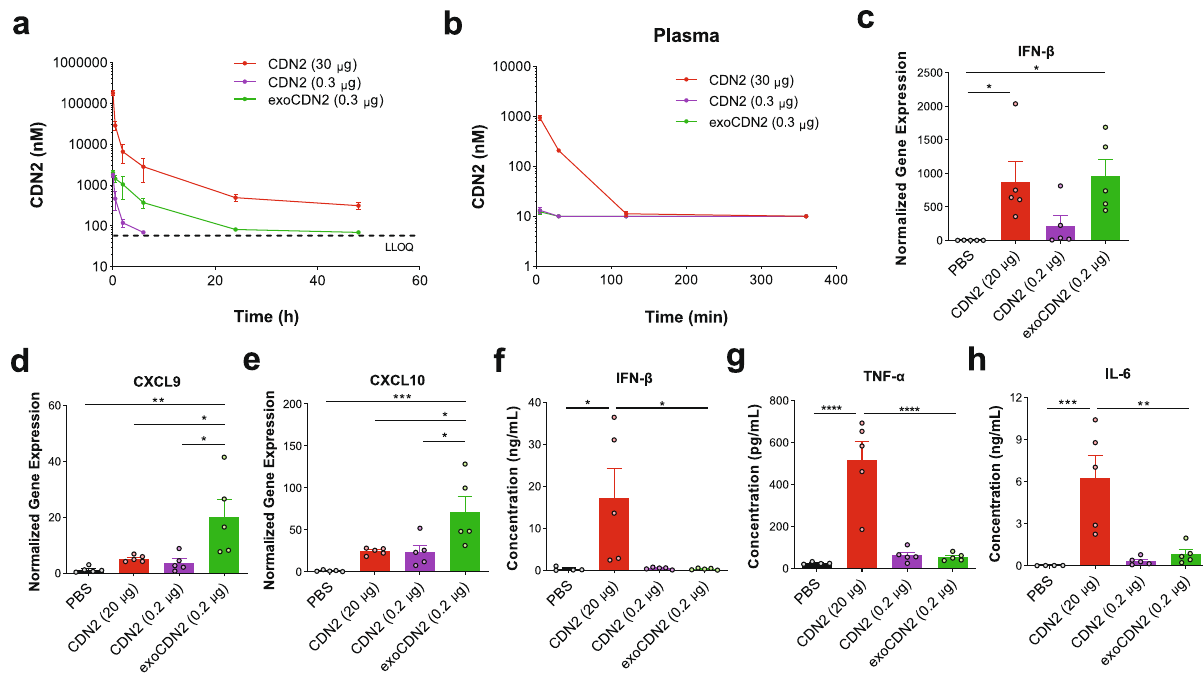
Fig. 3 Intra-tumoral administration of exoSTING enhances pharmacokinetics of a CDN and immunostimulatory activity in tumor microenvironment. a – h C57BL/6 mice were implanted subcutaneously with 1 × 10 6 B16F10 cells. Concentration of CDN2 in tumors ( a ) and plasma ( b ) was measured by LC- MS/MS at 5 and 30 min, 2, 6, 24, and 48 h after single IT injection ( n = 3 animals per group at each time point, n = 6 animals for CDN2 (30 µ g) and exoCDN2 (0.2 µ g) at 5 and 30 min, 2 and 6 h). c – e Four hours after IT injection, RNAs were puri fi ed from tumors ( n = 5 animals per group) and serum was collected. Relative expression of IFN- β ( c ), CXCL9 ( d ), and CXCL10 ( e ) genes was measured by RT-qPCR, normalized against the housekeeping gene RPS13 . Serum levels of IFN- β ( f ), TNF- α ( g ), and IL-6 ( h ) were measured ( n = 5 animals per group). Data are presented as means ± s.e.m from replicate samples as indicated. *, P < 0.05; **, P < 0.01; ***, P < 0.001; ****, P < 0.0001 by one-way ANOVA with Tukey ’ s multiple comparison